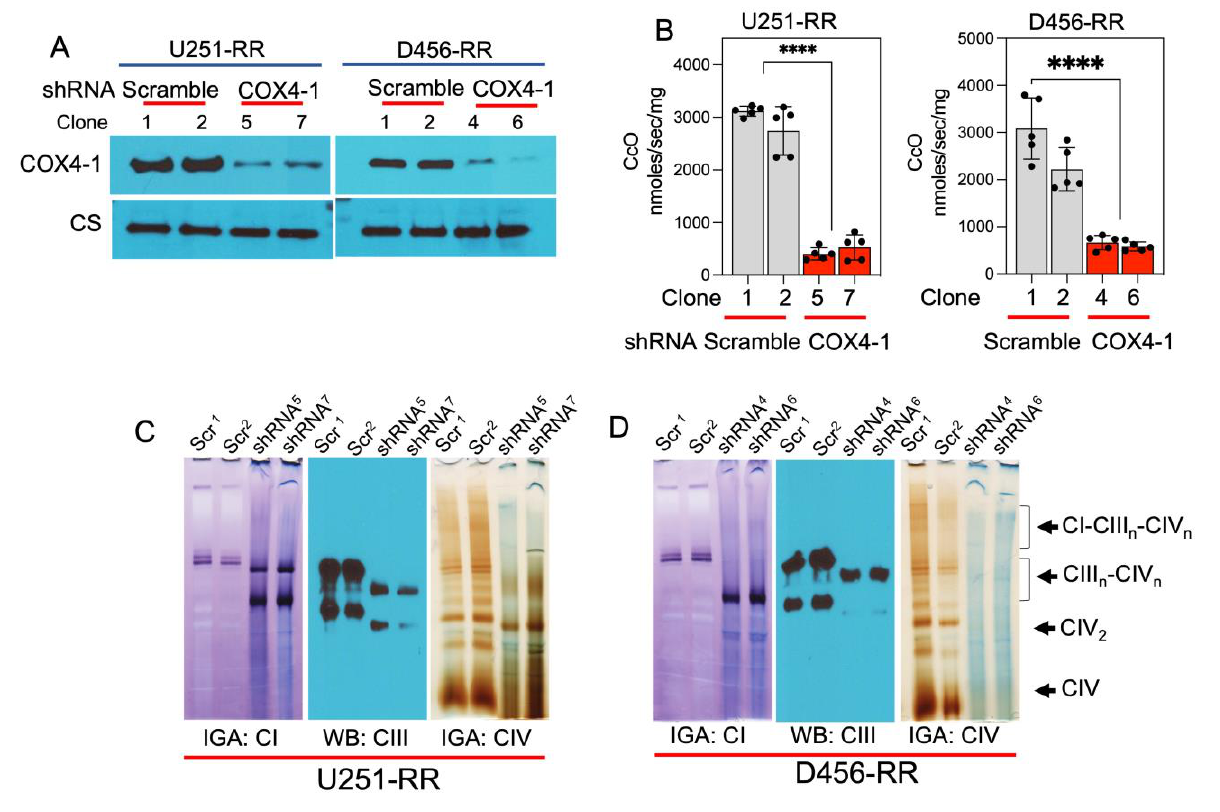
FIGURE 7: Silencing COX4-1 reduces SC assembly in in GBM cells with acquired radioresistance. (A) Representative Western blot showing COX4-1 expression in U251-RR and D456-RR cells transfected with shRNA targeting COX4-1 or scramble shRNA. Citrate synthase (CS) served as the loading control. (B) Quantification of CcO activity in in U251-RR and D456-RR cells transfected with shRNA targeting COX4-1 or scram- ble shRNA. Data are presented as the mean ± SEM (n=3) (C) Digitonin-solubilized mitochondria from the indicated cell lines were subjected to BN-PAGE followed by complex I and IV IGA assays and complex III Western blot analysis. Representative images from 4 independent prepara- tions. p < 0.0001 (****), calculated by Student